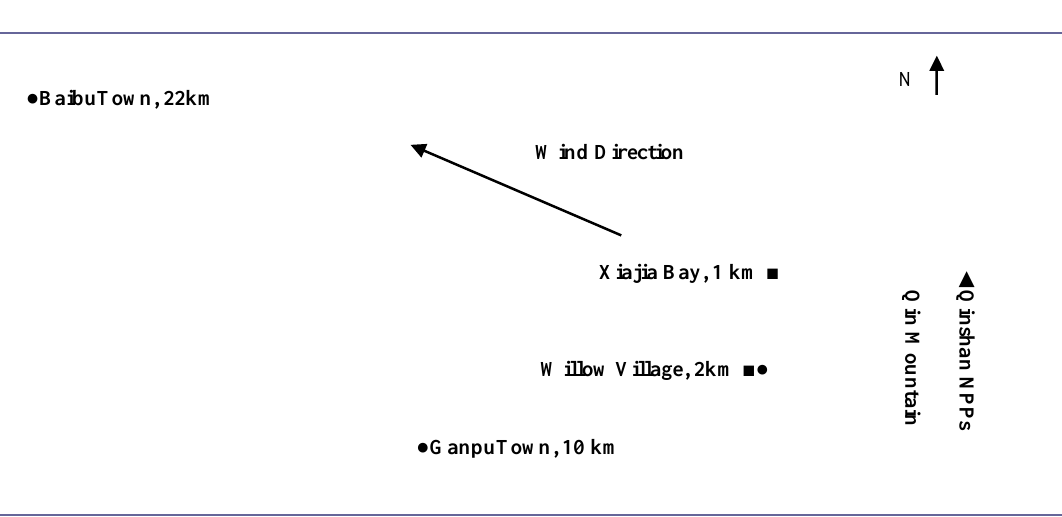
Figure 1. Sketch of wind direction, sampling points and monitoring sites. ■ Monitoring sites in reference 2; ● Sampling Point in this